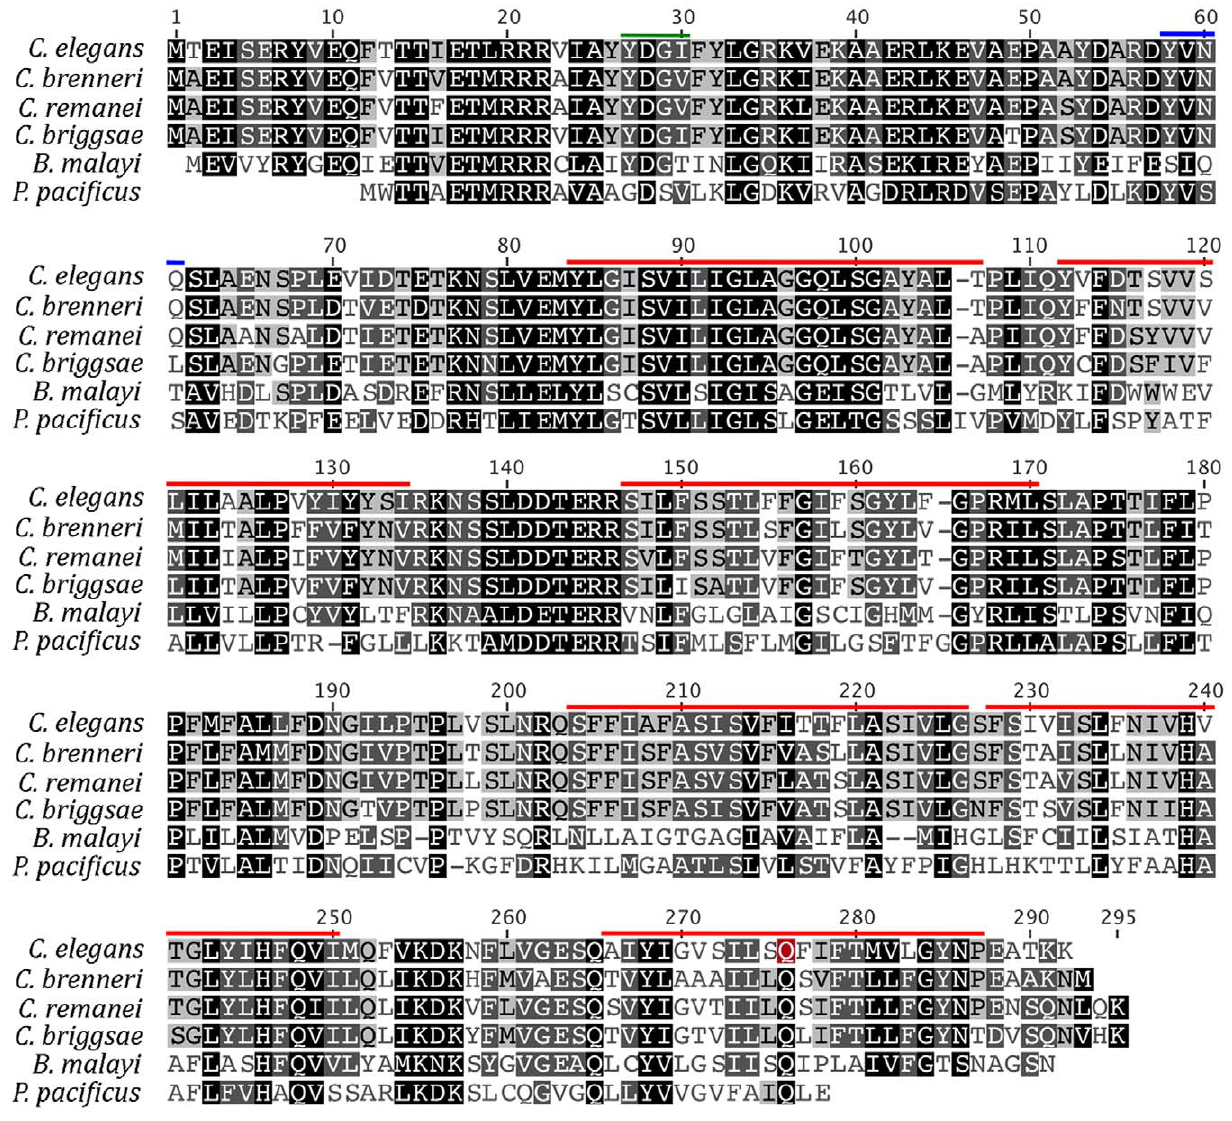
Figure 3. An alignment of the C.elegans SPE-46 protein sequence with those identified as homologs in other nematode species. The Geneious Alignment option with Blosum62 cost matrix generated the alignment. Red bars represent predicted transmembrane domains. The green bar represents a predicted Tyr-based sorting signal, and the blue bar represents both a predicted Tyr phosphorylation site and a predicted SH2 binding domain. The Q residue highlighted in red is transformed into a stop codon by the hc197 mutation. found a defect in embryogenesis, but only at 25 u C. Of 89 fertilized eggs laid by spe-46(hc197) hermaphrodites at 25 u C, only 41 hatched, giving an embryonic failure rate of 53.9%. The embryonic failure rate was 0% at 20 u C (of 82 eggs) and 1.6% at 15 u C (of 125 eggs). Every hatchling at all three temperatures survived to adulthood. This embryonic failure rate at 25 u C was rescued in transgenic worms: all 128 eggs laid were fertilized, and 116 hatched, for a failure rate of only 9.4%. Given the sperm specificity of spe-46 expression, the observed embryonic failure is likely due to sperm that fertilized oocytes but were incapable of producing viable embryos. We found that nearly 20% of the sperm